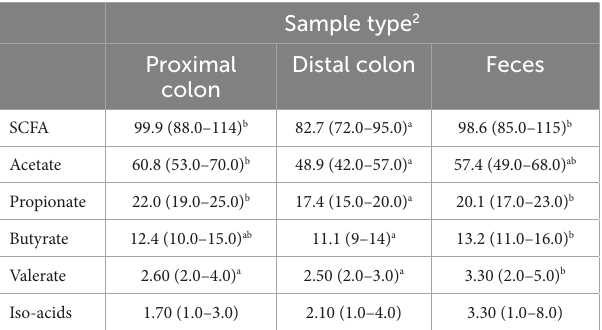
TABLE 4 Concentration (mmol/kg wet sample) of short-chain fatty acids (SCFA) in proximal and distal colon digesta and in fecal samples 1